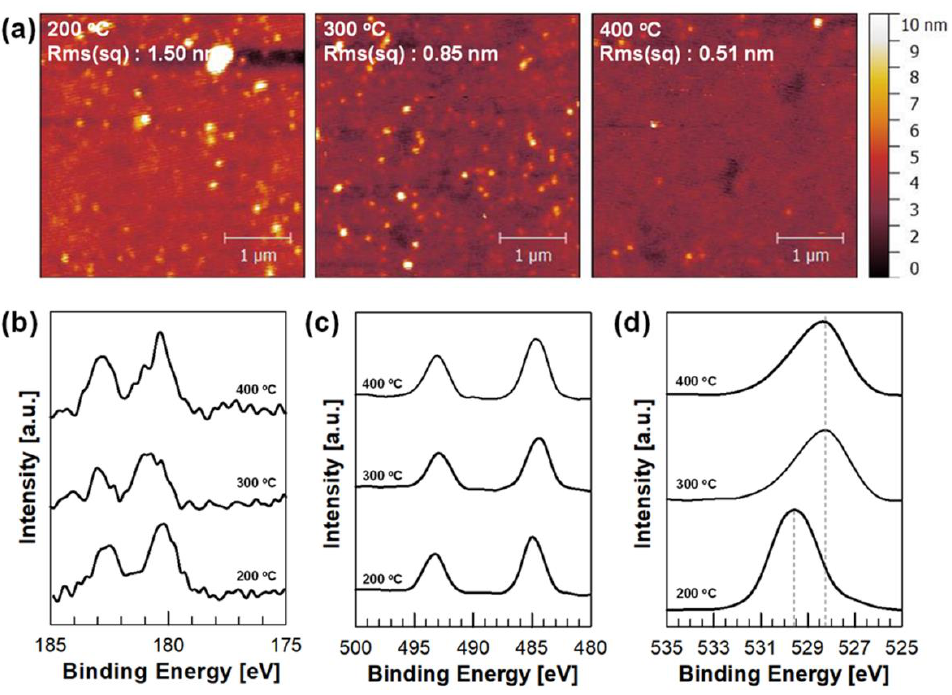
Figure 2. AFM topographic images ( a ) and XPS binding energy spectra for Zr 3d ( b ), Sn 3d ( c ), and O 1s ( d ) of sol-gel-driven ZrSnO 4 films.